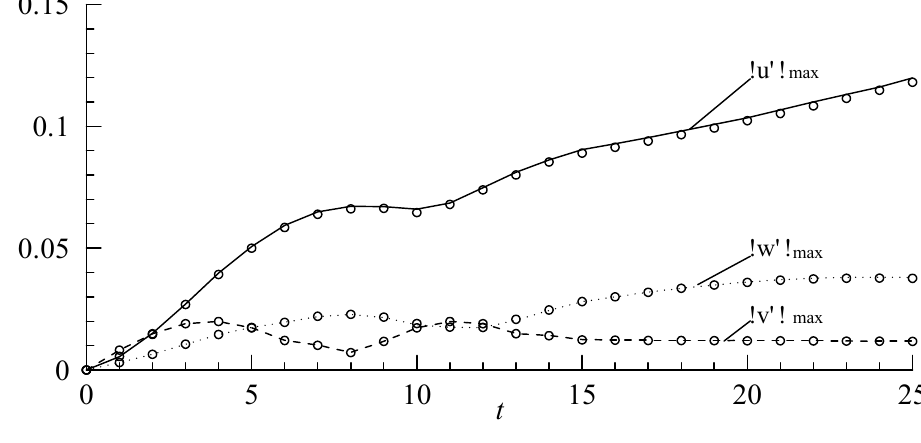
Figure 2. Mesh and time-step independence verification.